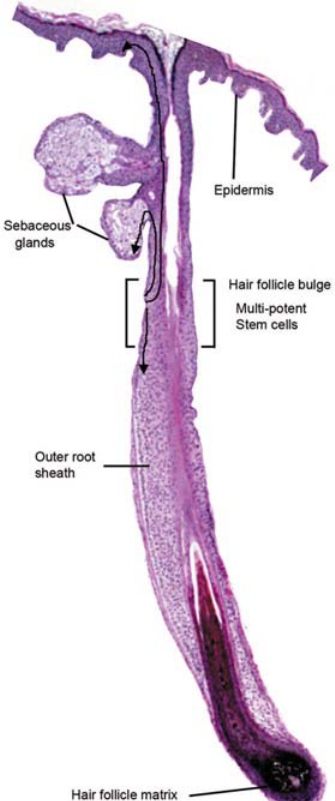
Figure 4 . Hair follicle bulge and multipotent stem cells. Reproduced from [19] with permission from Wolters